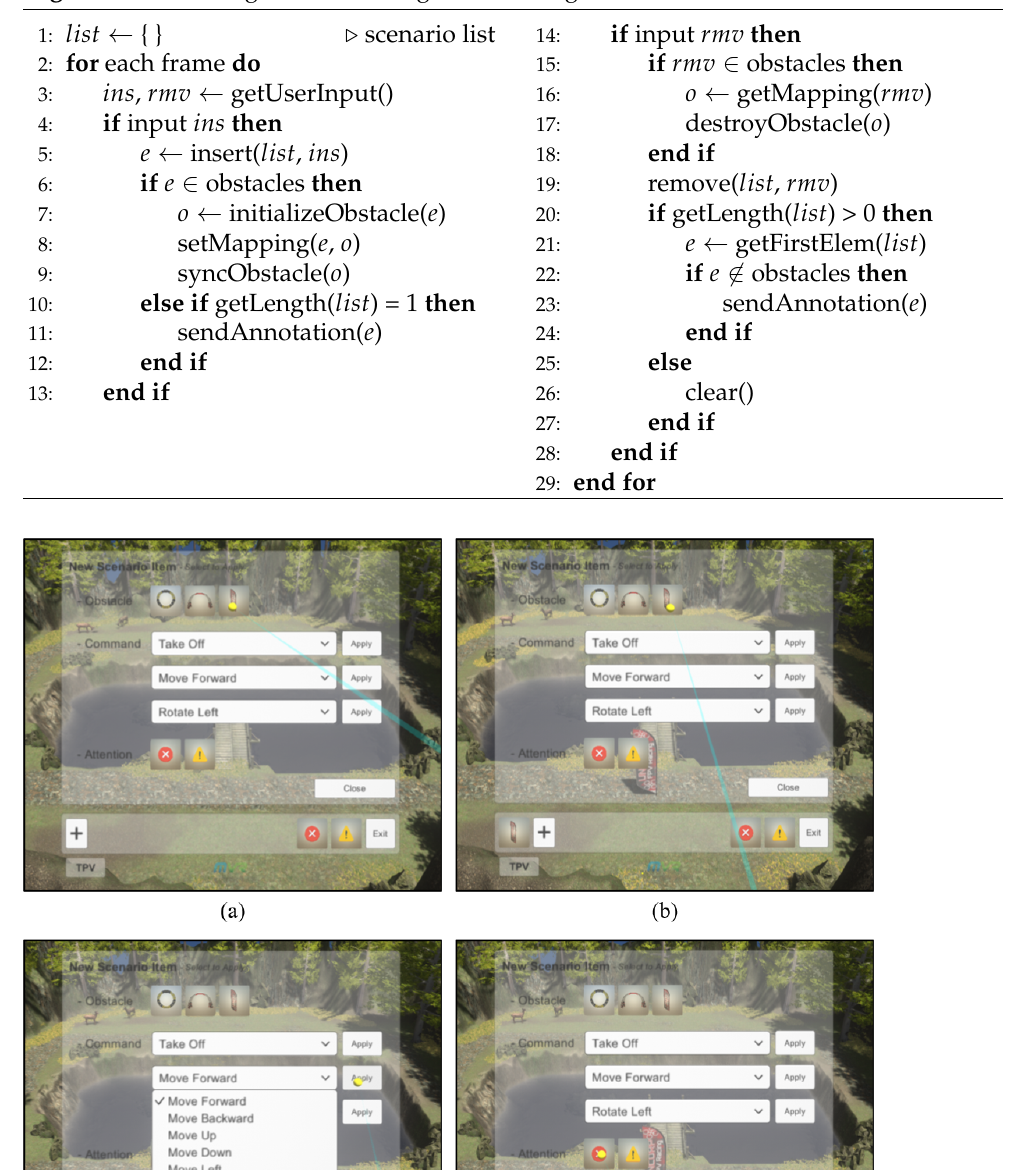
Algorithm 1 Training scenario configuration using extension tools